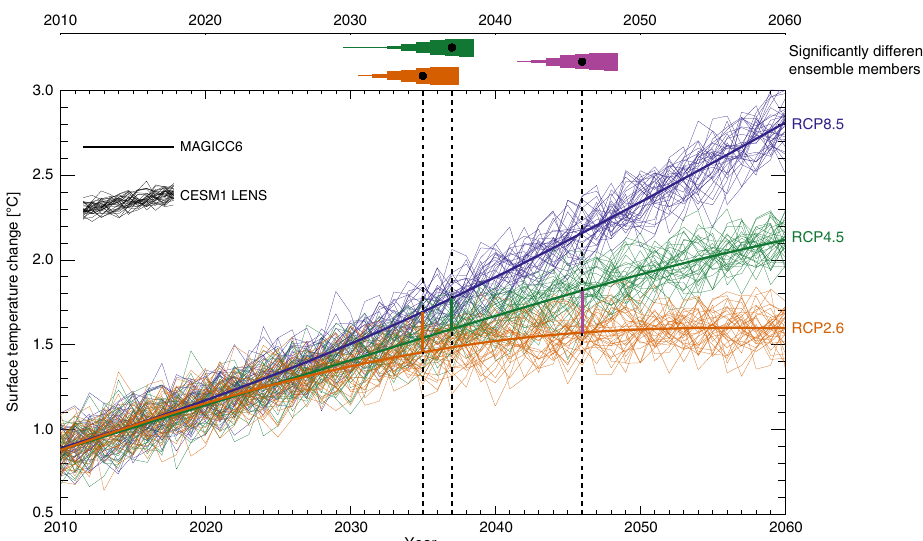
Fig. 1 Surface temperature response to multi-component mitigation. Emergence of a temperature signal when going from one RCP emissions pathway to another. Thick lines show calculations from MAGICC6. Thin lines show evolutions of interannual variability of global mean surface temperature, extracted from the CESM1 LENS. Triangles above the graphs indicate the number of ensemble members where the temperature difference between the RCPs is signi fi cant, when accounting for internal